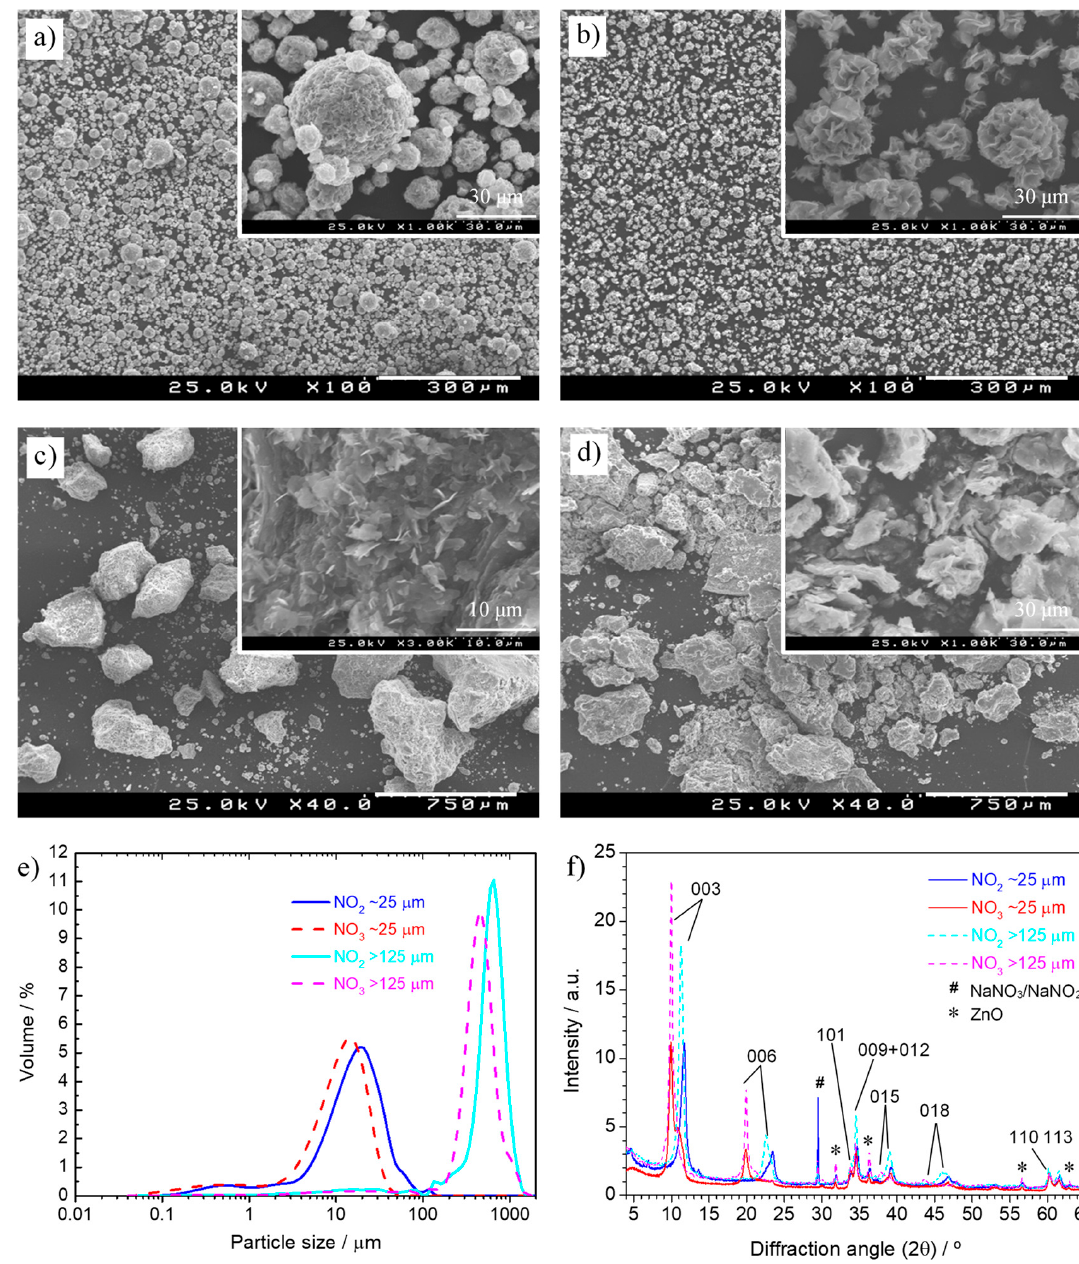
Figure 1. Scanning electron microscopy (SEM) images of ( a ) ZnAl-NO 2 with mean particle size ~25 µ m, ( b ) ZnAl-NO 3 with mean particle size ~25 µ m, ( c ) ZnAl-NO 2 with particle size > 125 µ m, ( d ) ZnAl-NO 3 with mean particle size > 125 µ m; ( e ) particle size distribution of the layered double hydroxide (LDH) powders; ( f ) XRD di ff ractograms of the four LDH powders.